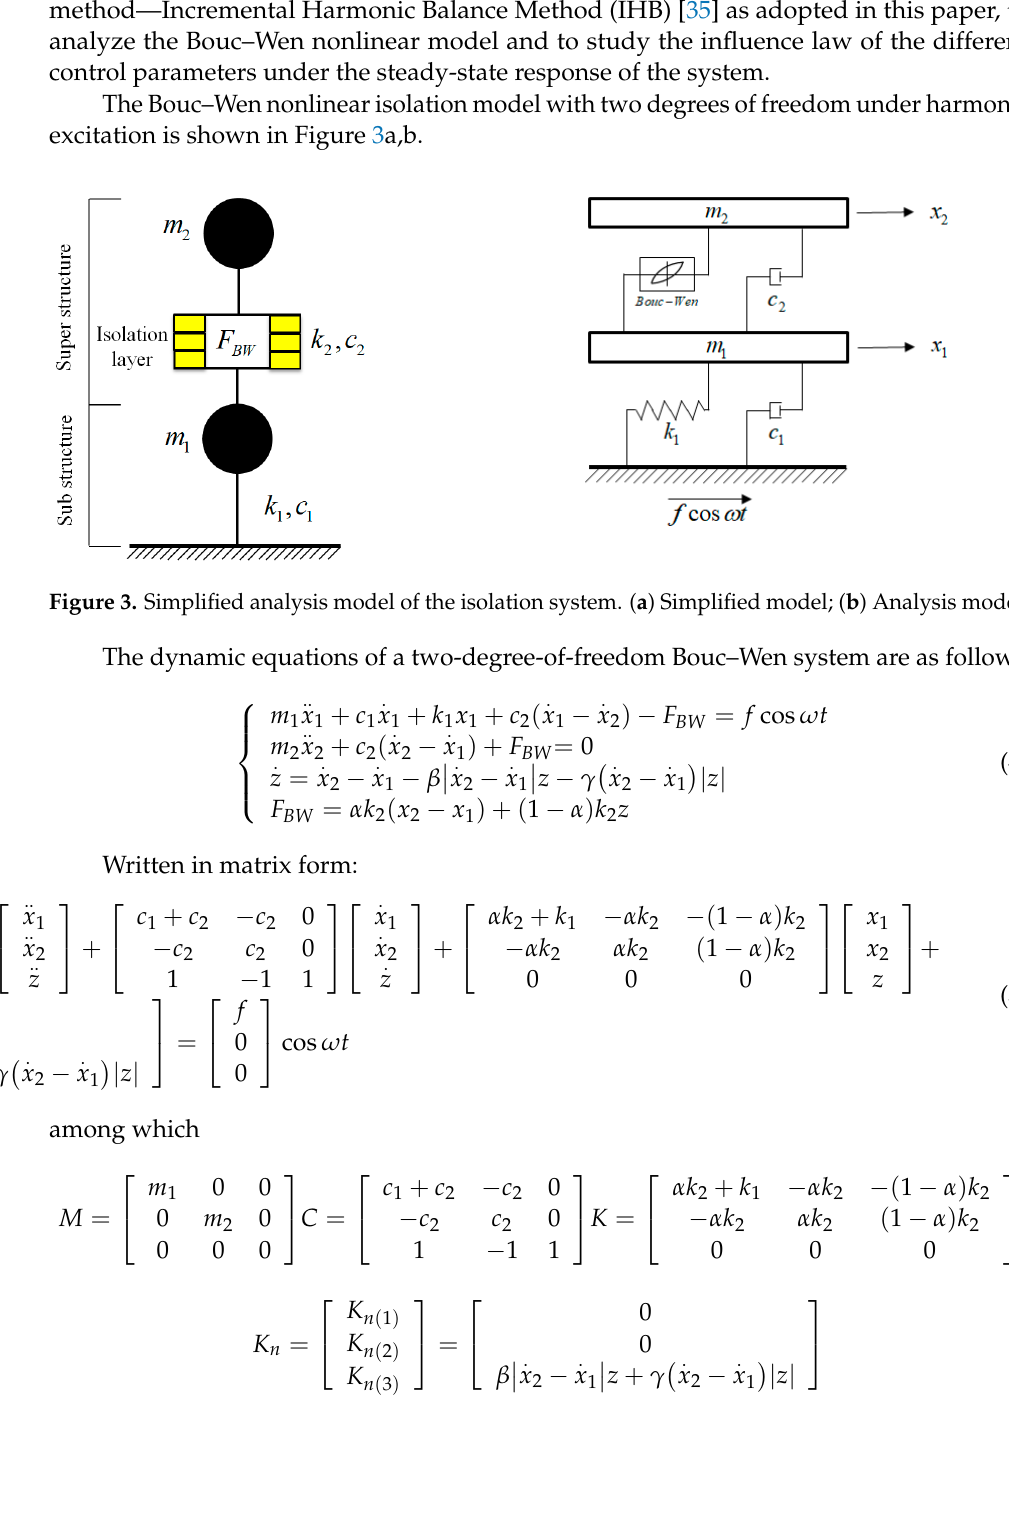
Figure 2. Bouc – Wen hysteresis loops with different parameters. (The values of β in ( a–d ) are 0.15, 0.5, 0.15, 0.5; The values of γ in ( a–d ) are 0.85, 0.5, − 0.85, − 0.5.)